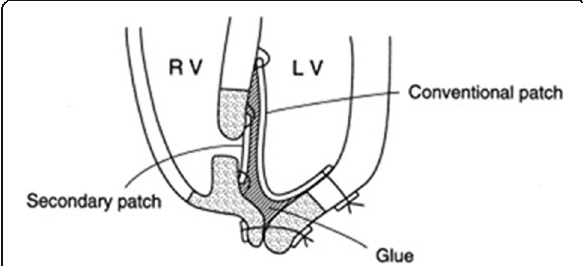
Fig. 4 Modified infarct-exclusion technique with double patch and application of biological